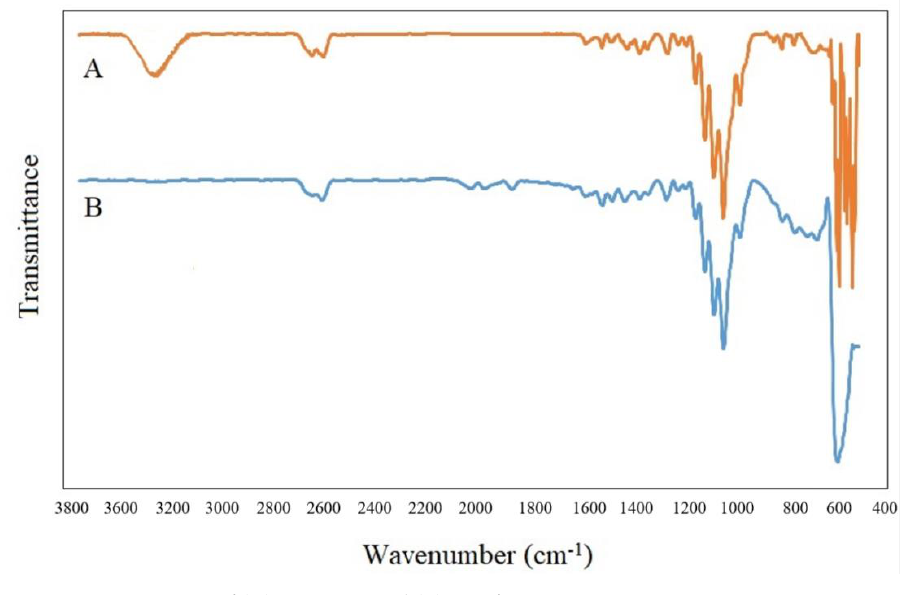
Figure 3. FTIR spectra of (A) neat LPS and (B) LPS/CNPs 3%.